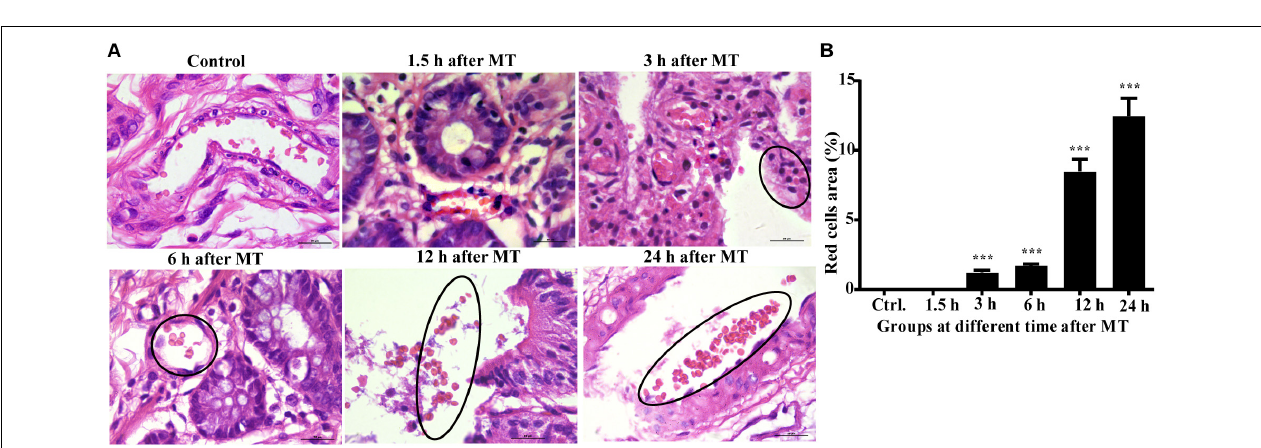
FIGURE 4 | The morphology of the capillaries and red blood cells in the cecal mucosa of the SD rats at different time points after MT (1,000 × ). (A) HE staining in the cecal mucosa in SD rats at different time points after MT (1,000 × ). No obvious changes were observed in the control and 1.5 h. The areas in the black circle showed obvious red cells were found outside the capillaries in the time points of 3, 6, and 12 h after MT. There was obvious vascular wall damage at 24 h after MT. (B) Mean ( ± SEM) percentages of morphologically red blood areas at 3, 6, 12, and 24 h (*** P < 0.001 vs. the